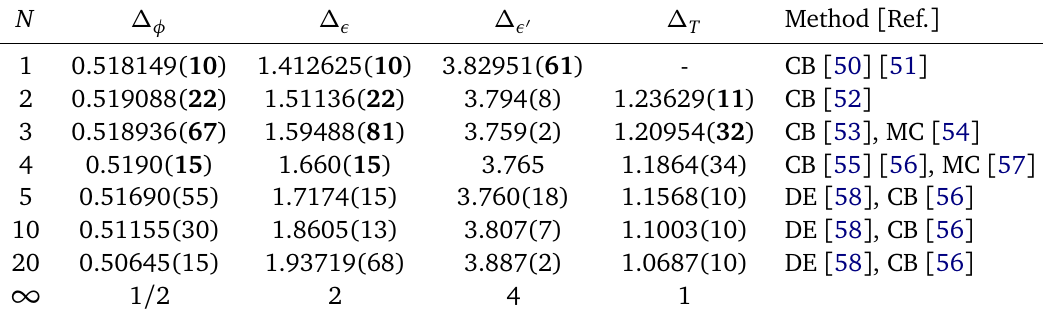
Table 1: Bulk critical exponents from the literature. CB stands for conformal boot- strap, MC for Monte Carlo and DE for derivative expansion. References [ 51 ] , [ 54 ] and [ 57 ] are only used for ∆ ε (cid:48) . In particular, the value from [ 57 ] was taken from its table 10, where the error is not reported. Reference [ 56 ] is only used for ∆ the remaining assignments are unambiguous. As for the errors, the ones in the CB come in two flavors. Values in bold indicate rigorous errors, while values in regular font are from bootstrap techniques where the uncertainty is not